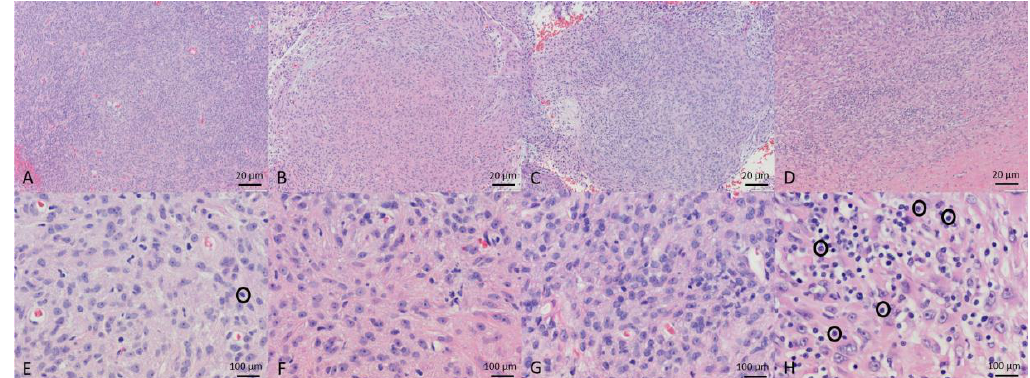
Figure 3. Microscopic images of tissue sections from Dog 5. Biopsy samples were collected before MYXVΔserp2 treatment ( A , E ) and on Days 4 ( B , F ) and 14 ( C , G ) post-treatment. Sections from the